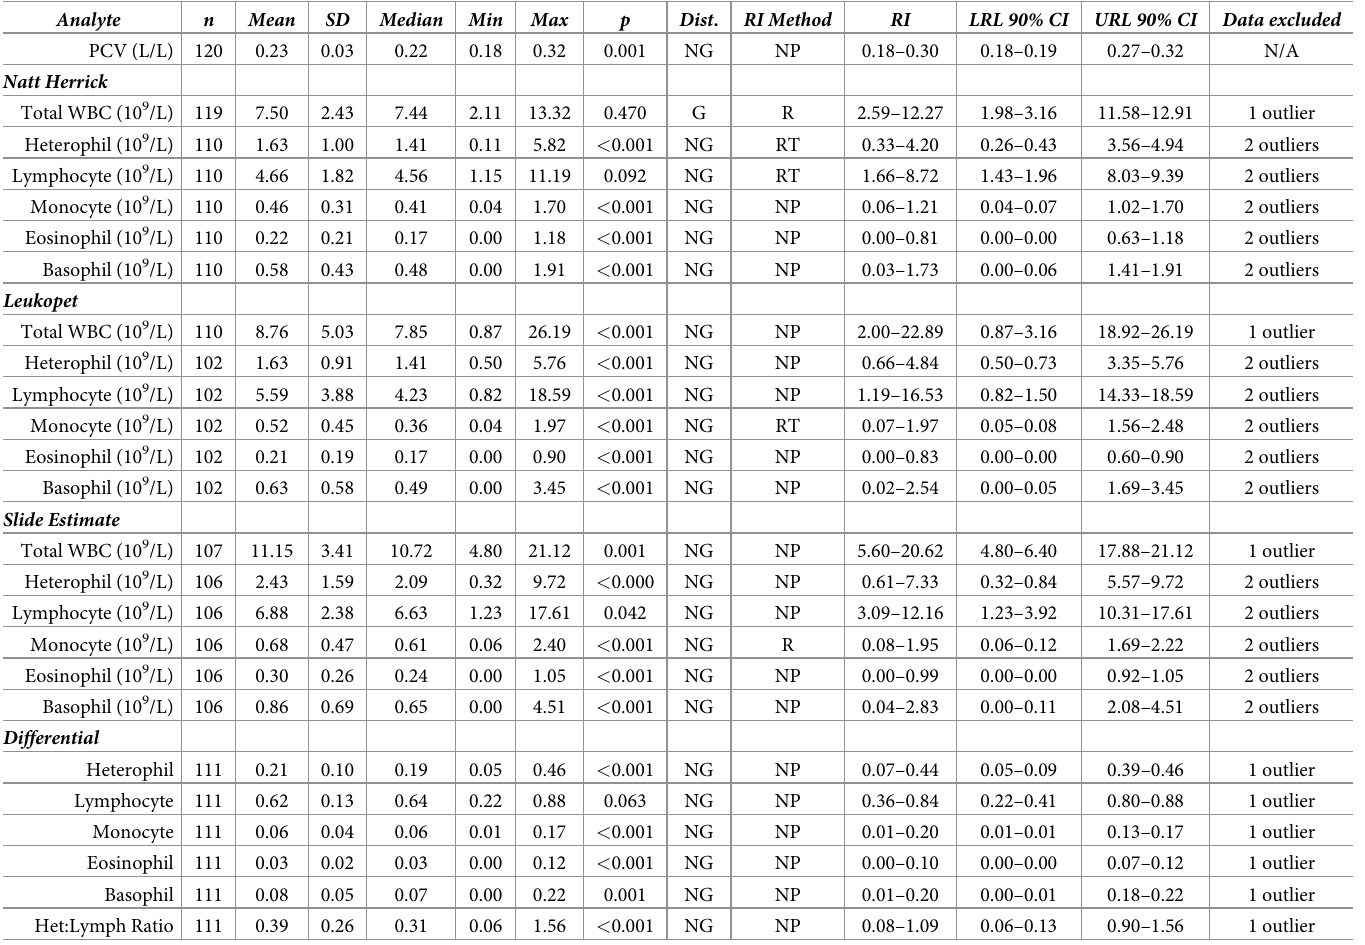
Table 1. Subadult radiated tortoise hematology reference intervals and descriptive statistics based on clinically healthy individuals living in a rehabilitation setting within their natural